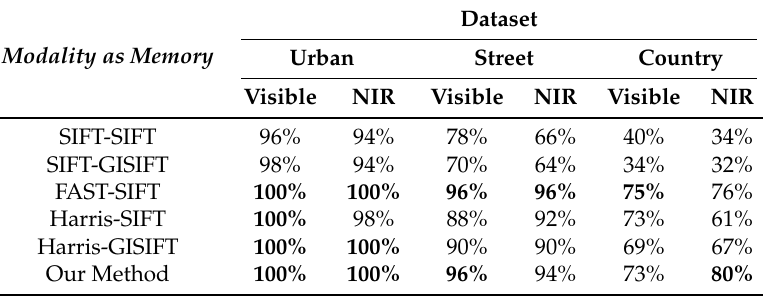
Figure 13. A Visible-NIR pair from the “EPFL” dataset. Table 1. Results (matching ratio) on Visible-NIR